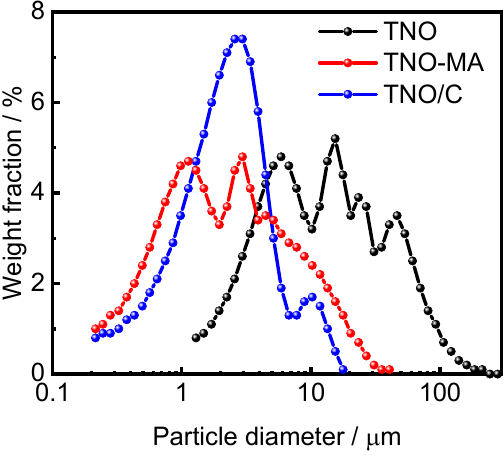
Figure 4. Particle size distributions for TNO, TNO-MA, and TNO/C.